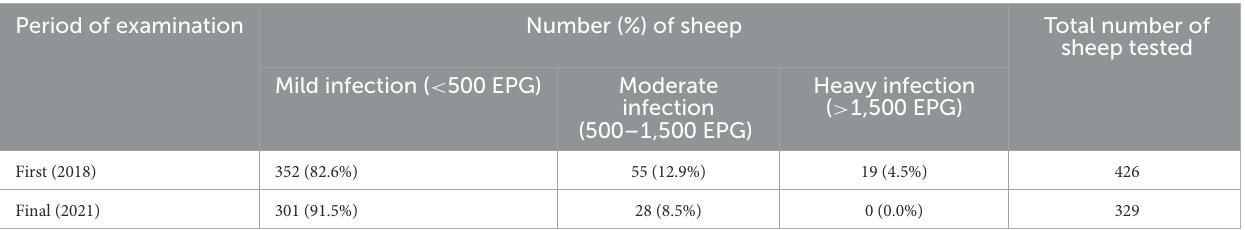
TABLE 3 Categorization of sheep in three infection levels based on egg burden at the first (2018) and final (2021) pre-deworming sampling of the intervention. Period of examination